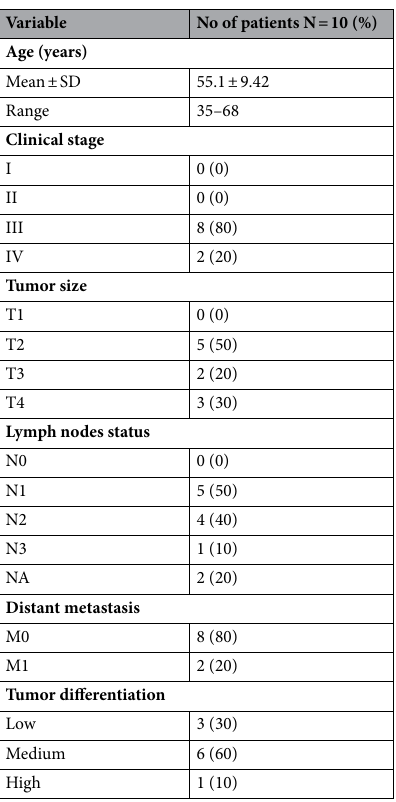
Table 1. The clinicopathological data of 10 hypopharyngeal carcinoma